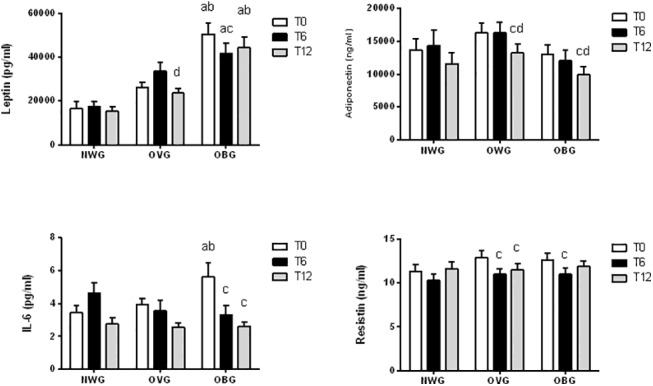
Effect of exercise on adipokines in normal weight (NWG), overweight (OVG) and obese (OBG) groups.Plasma and serum was separated immediately after blood collection before (T0), after 6 months (T6) and 12 months (T12) of the exercise training program. The plasma or serum concentrations of leptin, adiponectin, IL-6 and resistin were determined using an Enzyme-linked immunosorbent assay (ELISA) method. The values presented are the mean ± standard error of mean. a comparison to normal weight group; b comparison to overweight group; c comparison to before program training (T0); d comparison to after 6 months of program training.